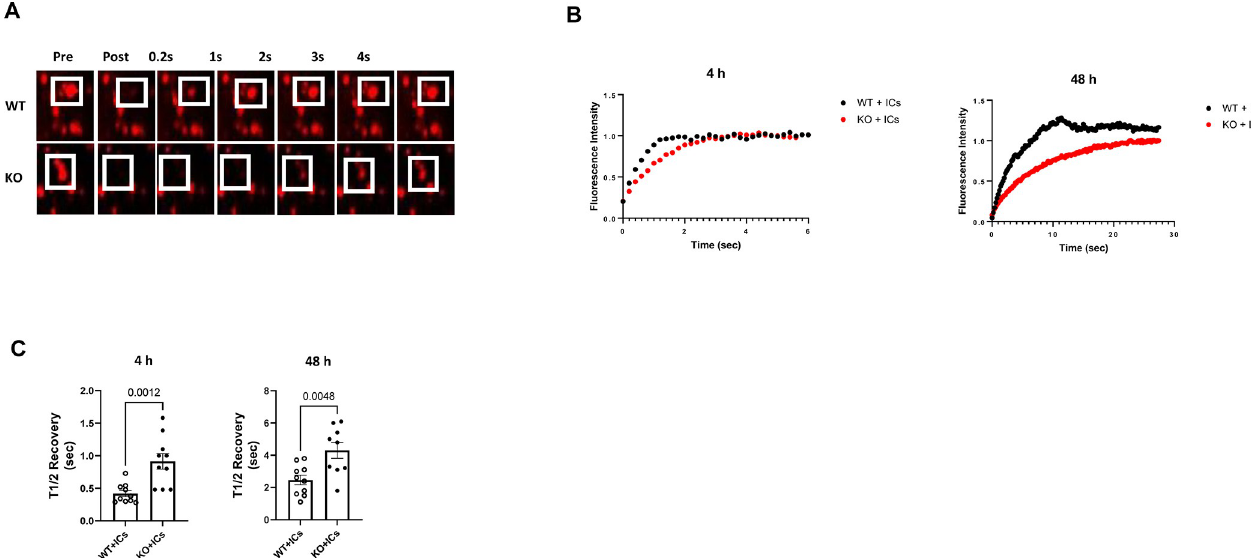
Fig 5. Cathepsin B activity is significantly reduced in FcRn KO podocytes after treatment with ICs. A , Representative pre and post bleach images for WT or KO podocytes treated with ICs. Square indicates the bleached area. B , Representative post bleach fluorescence intensity versus time curves for WT or FcRn KO podocyte treated with ICs for 4 hours or 48 hours. C , T 1/2 recovery for WT or KO podocytes treated with ICs for 4 hours or 48 hours, n = 4 independent experiments.